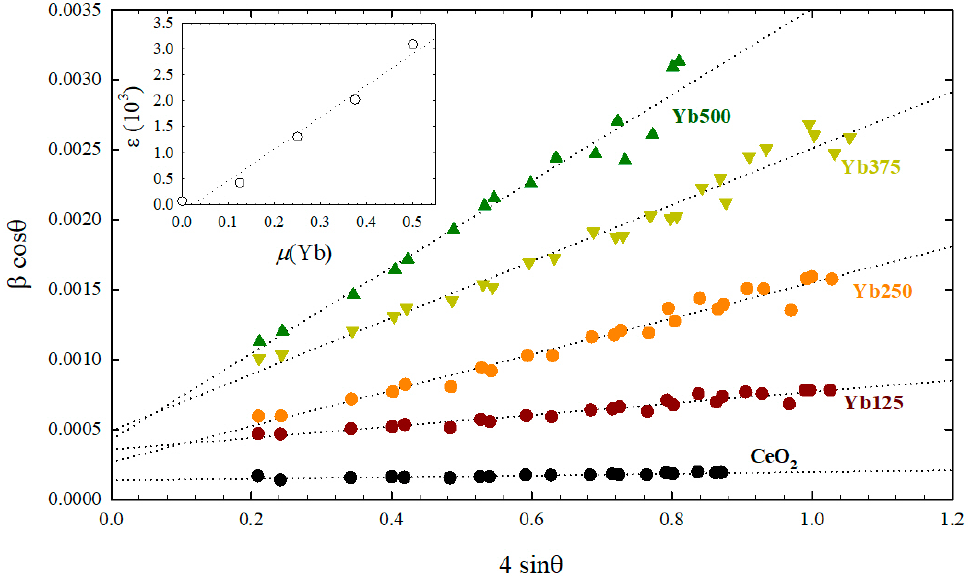
Figure 2. Williamson–Hall plots for different compositions. The inset reports the evolution of the lattice strain with the Yb concentration.